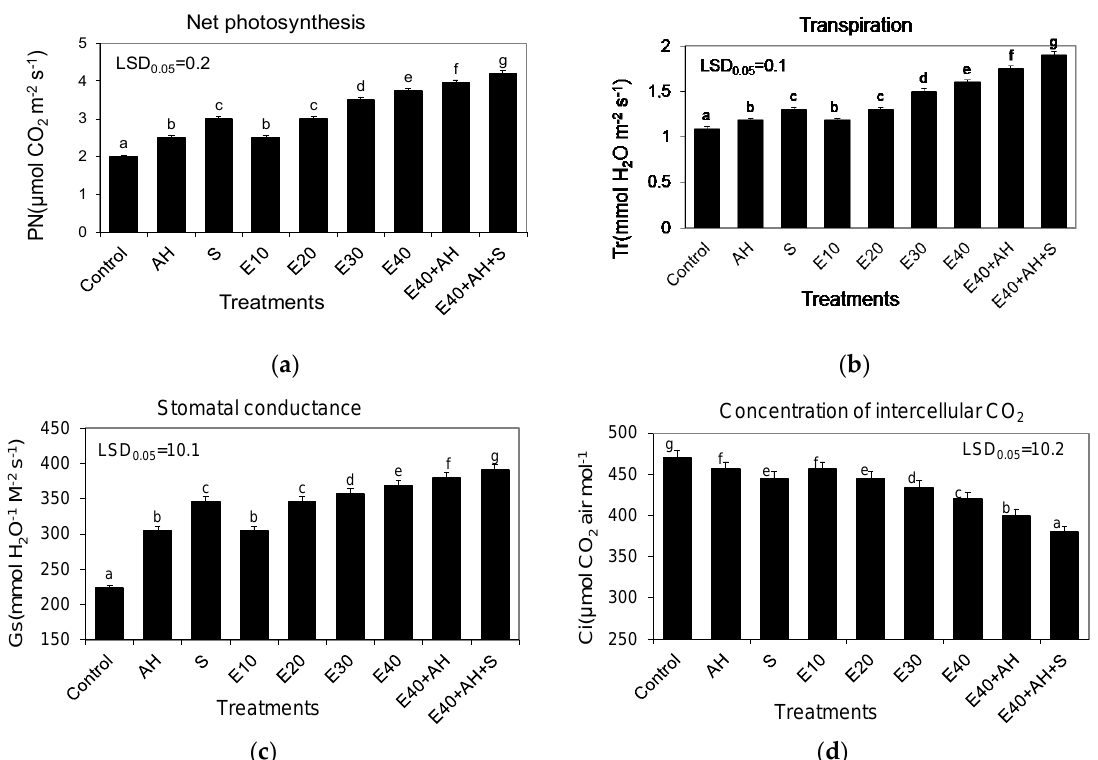
Figure 3. Gas exchange in the leaves of Jerusalem artichoke plants (Net photosynthesis ( a ), Transpiration ( b ), Stomatal conductance ( c ), Concentration of intercellular CO 2 ( d )) cultivated in a field and fertilized with liquid non-centrifuged waste from corn grain digestion to methane (E10, 40 m 3 ha −1 ), Apol-humus (AH; 10 L ha −1 ), and Stymjod (S; 5 L ha −1 ). The data marked with the same letters are not significantly different, according to a Newman–Keuls multiple range test at an alpha level of 0.05. The data presented are the average over the years and 10 plants in each repetition of a particular experimental variant.